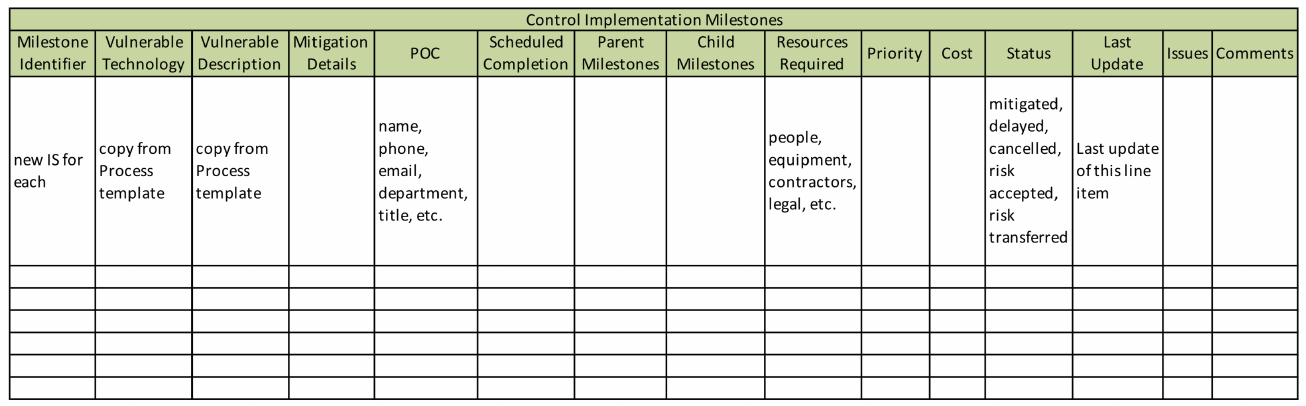
Figure 8. Control Implementation